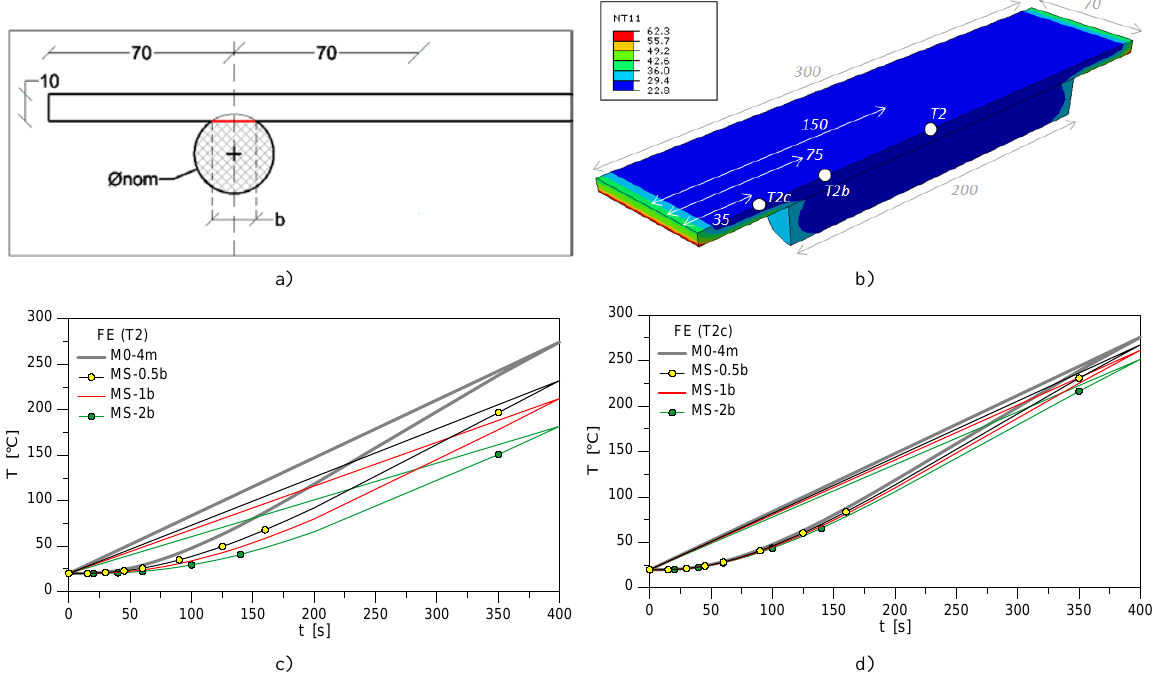
Fig. 7 Thermal analyses on the MS models: a) geometrical description of steel supports (cross-section), with b) temperature scenario after 125s of fire exposure and c)-d) temperature evolution in time for the T2 and T2c control points (nominal dimensions in mm).